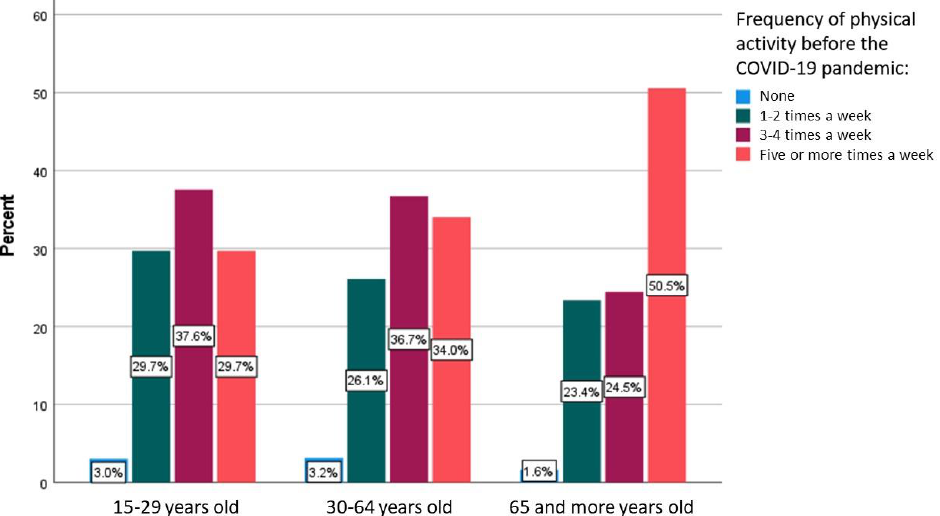
Figure 4. Frequency of physical activity before the COVID-19 pandemic among different age groups (N = 793). Note: Missing values are excluded from the calculation.